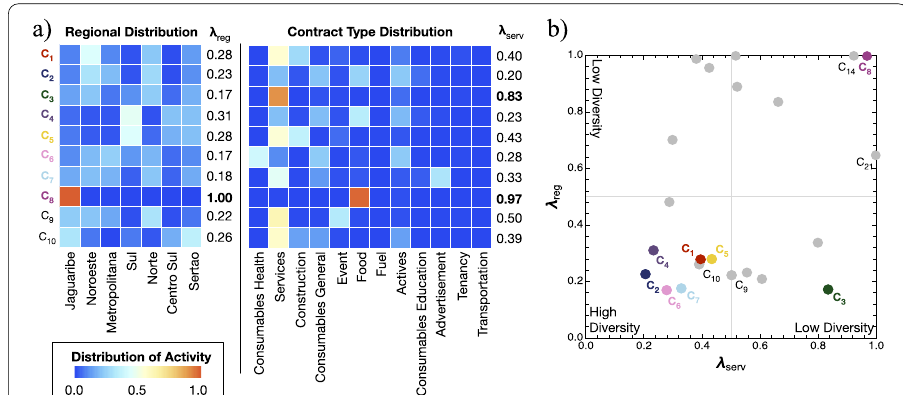
Fig. 4 Characterization of the ten largest communities by the diversity of bids done by region and type. Panel a shows the distribution of bids within each community by mesoregion (left) and contract/tender type (right). For each community we compute the Simpson’s diversity index ( (cid:31) reg and (cid:31) serv ). The full and official names of the mesoregions are: Jaguaribe; Noroeste Cearense (Noroeste); Metropolitana de Fortaleza (Metropolitana); Sul Cearense (Sul); Norte Cearense (Norte); Centro-Sul Cearense (Centrol Sul); and Sertoes Cearenses (Sertão). We use simplified references to these names for visualization purposes. Panel b compares communities by their diversity of contracts in terms of regional span and type. Note that in panel a we only show results for the ten largest communities, which are representative of the results. Communities not identified by a color code in Fig. 2 are shown in gray in panel b , in the particular community C 14 corresponds to the gray clique easily identifiable in the bottom left of the network in Fig.